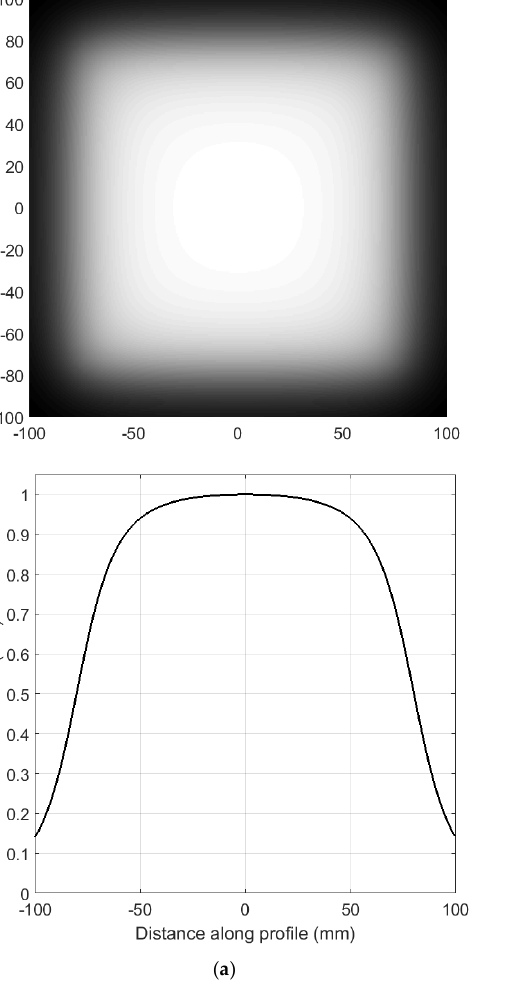
Figure 2. Irradiance map and central irradiance profile of square source of 160 × 160 mm 2 ; detector of 200 × 200 mm 2 ; z detector distance 20 mm. ( a )Flowline computation ( b ) Raytrace computation